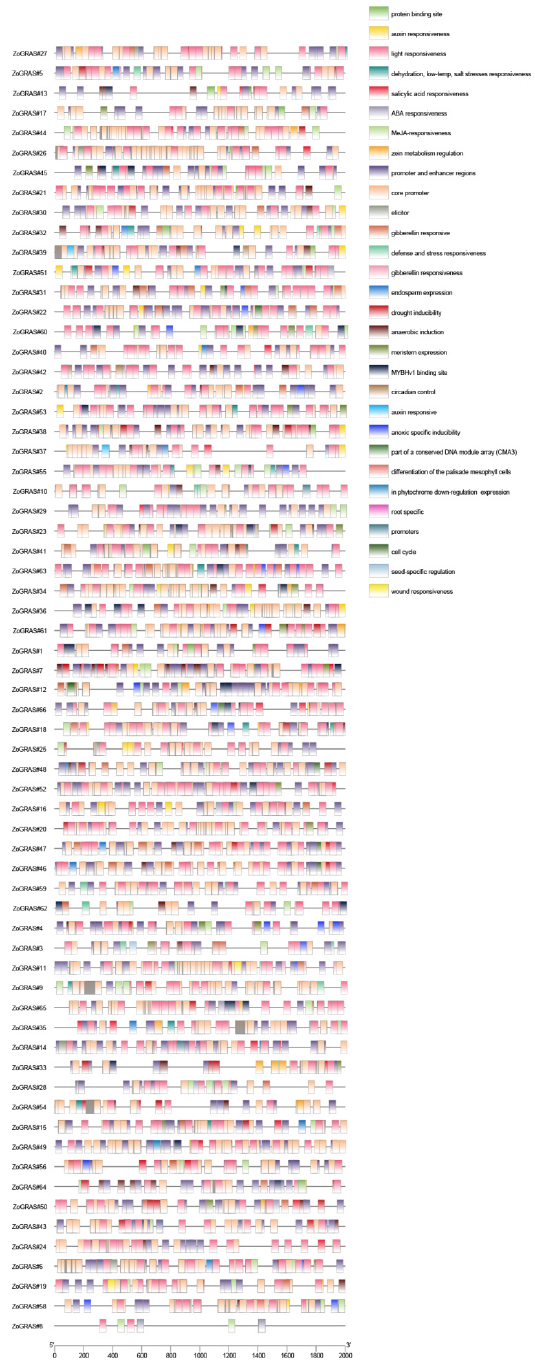
Figure 5. Cis-acting elements of ginger GRAS promoters. Different types of cis-acting elements are marked by different colors.